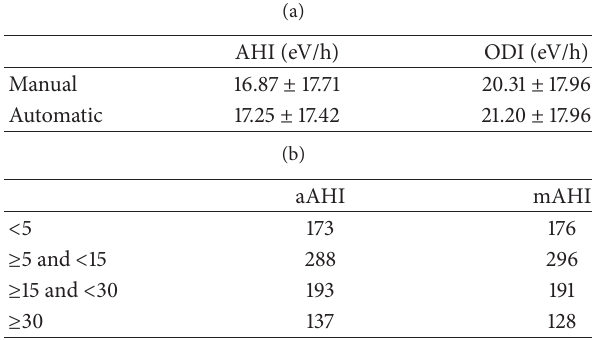
Table 2: (a) Automatic and manual indexes (AHI and ODI) from ApneaLink Plus. (b) Automatic and manual AHI for different grade of severity.